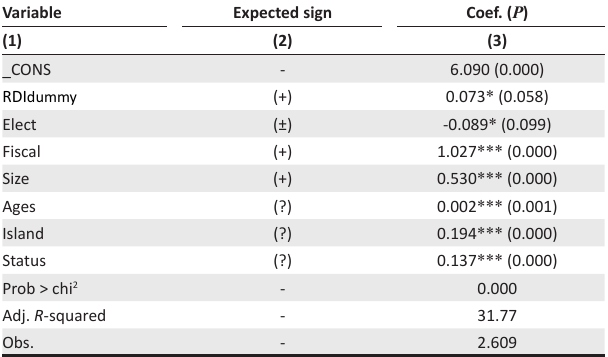
TABLE 6: Sensitivity test results.